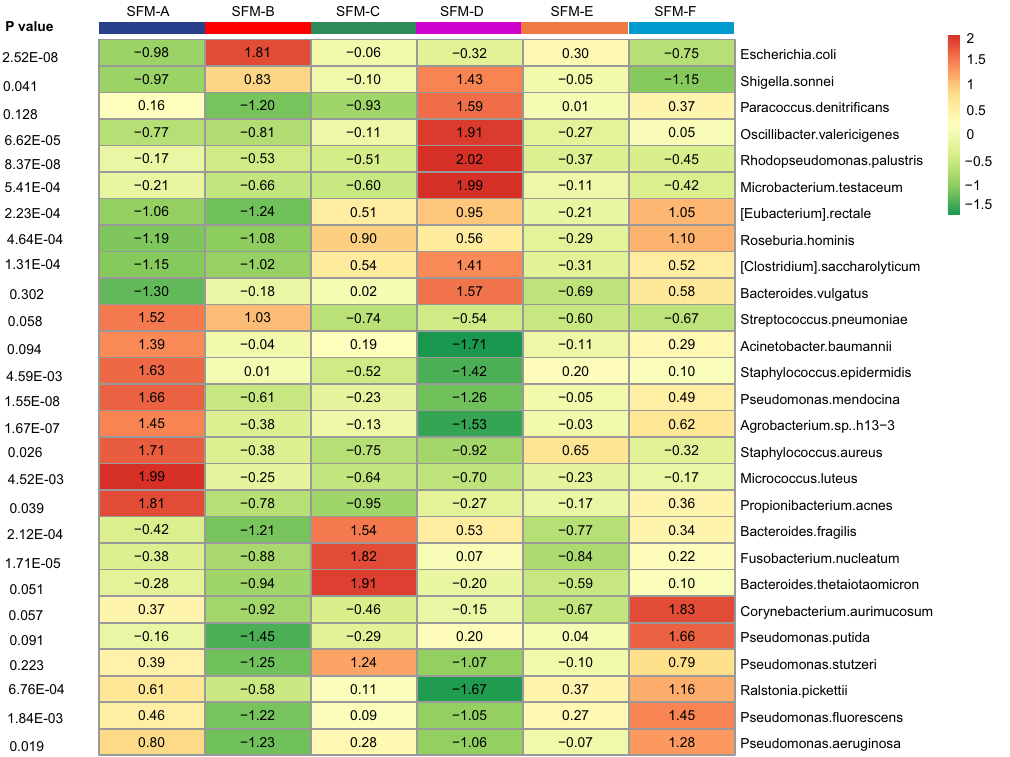
Fig. 5 Heatmap showing the relative abundance of dominant bacterial across SFM subtypes. Kruskal – Wallis test was used to test the differences across SFM